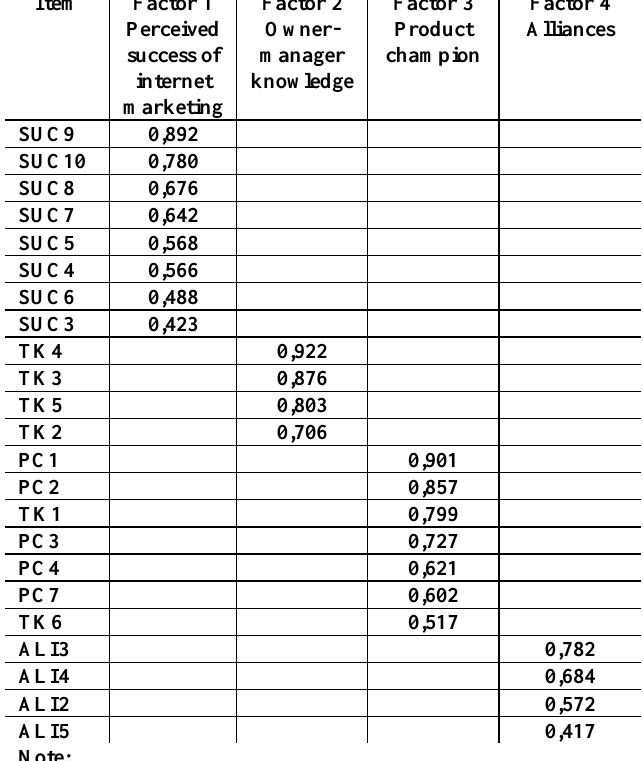
Table 1: Exploratory factor analysis